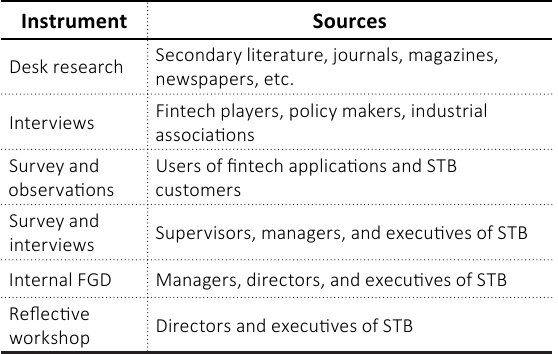
Table 1. External and internal